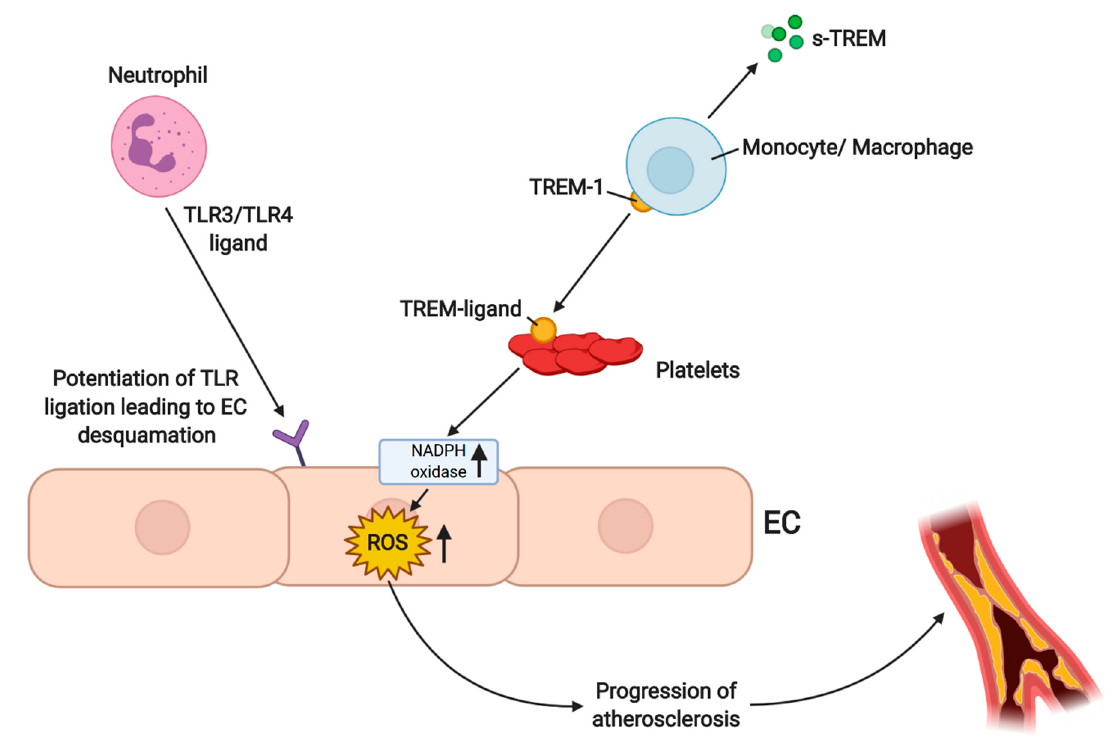
Figure 3. Neutrophils and monocytes/macrophages in peripheral artery disease (PAD). Neutrophils enhance the activation of monocytes via toll-like receptors (TLRs). TLRs are pattern recognition proteins, and their agonism leads to multiple important cellular mechanisms, like the generation of endoplasmic reticulum stress-ROS, and impairment of endothelial cell repair. Neutrophils potentiate TLR ligation leading to endothelial cell detachment and plaque erosion. Another mechanism indicating the role of neutrophils and monocytes/macrophages in oxidative stress shows that triggering receptors expressed on myeloid cells-1 (TREM-1), as an example of an inflammation marker, participate in the stimulation of these cells via interaction of TREM-ligand with TREM-1, which leads to an increased production of reactive oxygen species (ROS). Created with BioRender.